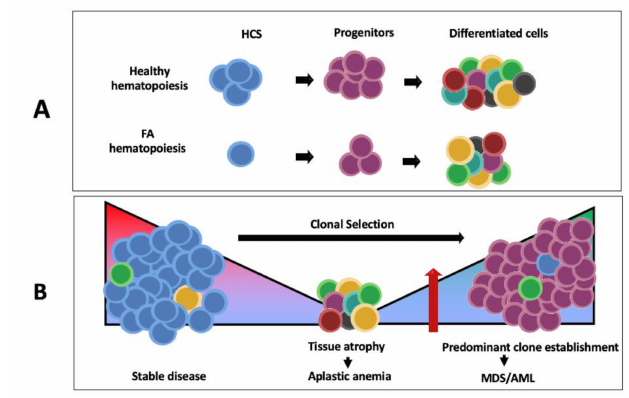
Figure 8. HSPCs in FA are subject to a strong selective pressure. ( A ) The reduced number of hematopoietic stem cells in the bone marrow of patients with FA leads to reduced numbers of progenitor cells and di ff erentiated cells. ( B ) Young patients with FA usually have a more stable disease, however DNA damage and environmental stressors might lead to a dramatic reduction in the number of HSPCs. This sweeping of fragile HSPCs might potentially select apoptosis-resistant hematopoietic clones with acquired somatic mutations that eventually could give rise to premalignant hematopoiesis, such as MDS or